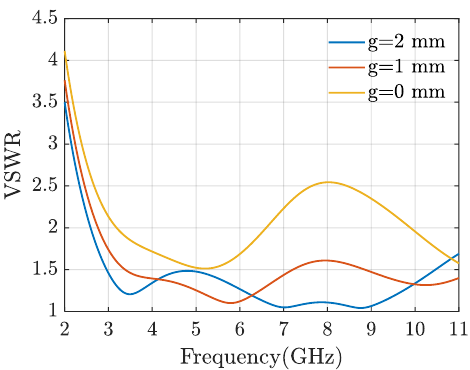
Figure 3. Simulated VSWR of the proposed antenna without notched bands in case of different g.